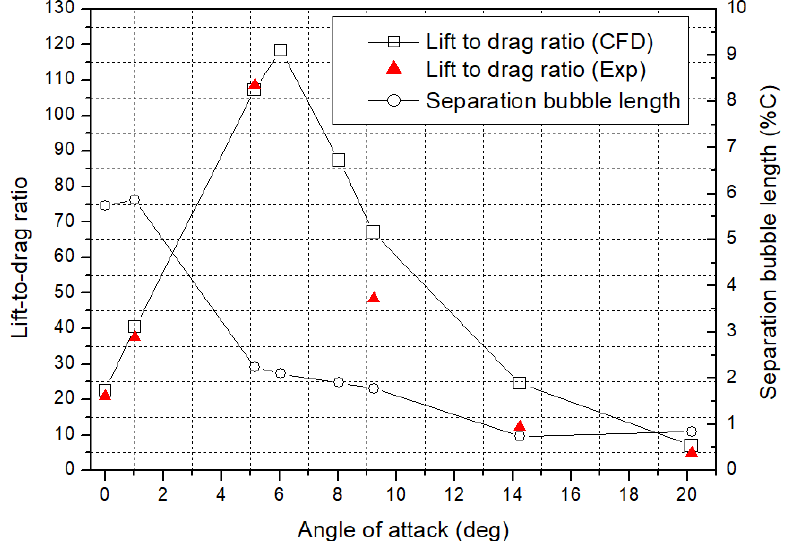
Figure 11. Extent of the separation bubble on the suction airfoil surface as a percentage of the chord length (line with empty circles) and effects on the airfoil lift-to-drag ratio (line with empty squares). The solid line with green squares represents experimental data points.